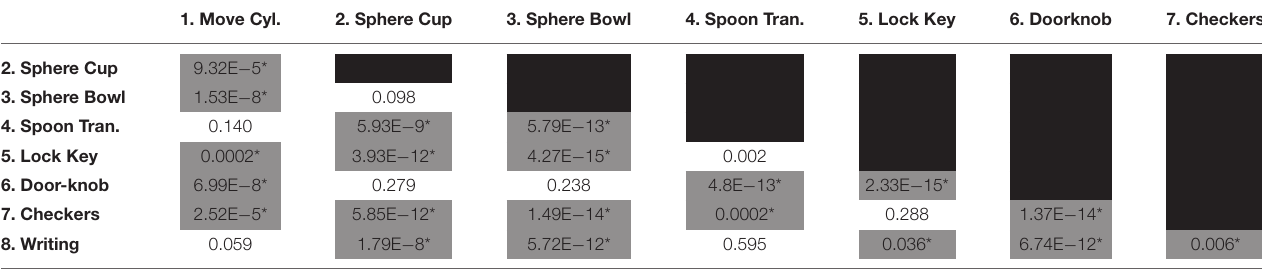
took the most attempts to complete in VR. The Spoon